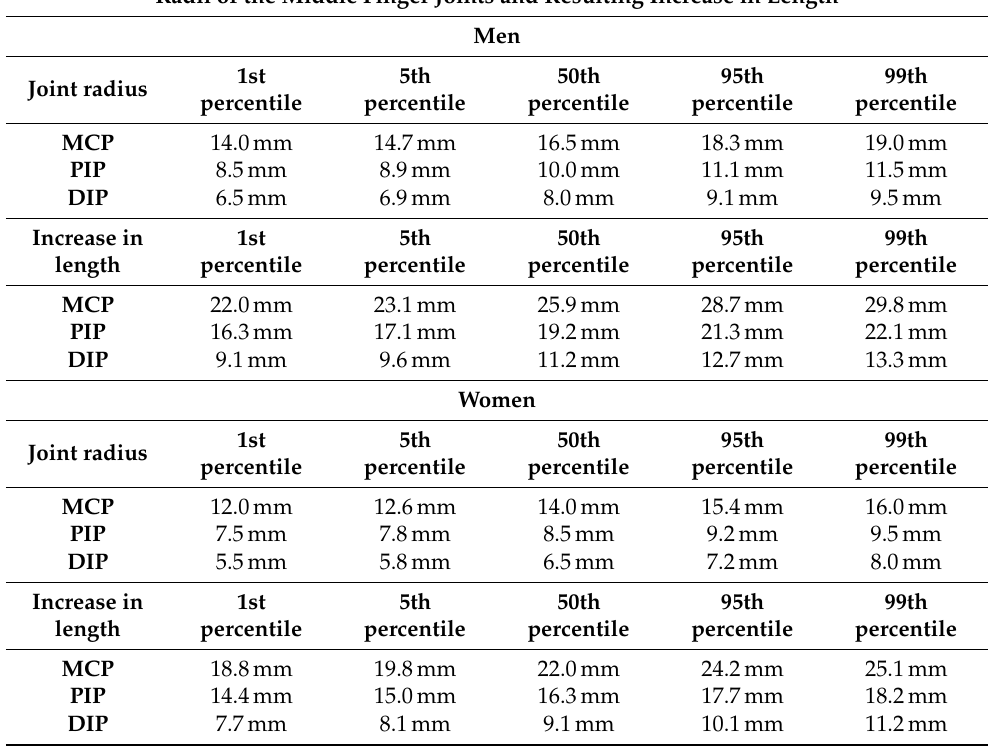
Table A3. Radii of the middle finger joints Distal Interphalangeal (DIP), Metacarpophalangeal (MCP) and Proximal Interphalangeal (PIP), according to [46] and resulting increase in skin length over them. Radii of the Middle Finger Joints and Resulting Increase in Length